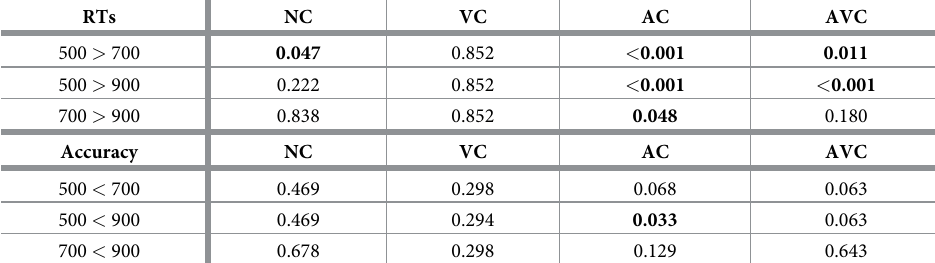
Table 4. Benjamini-Hochberg adjusted p-values from paired one-sided t-tests for differences between SOAs (all pairings) within each cue type, for reaction times (RTs) and accuracy ( α = 0.05). Statistically significant values are in bold.